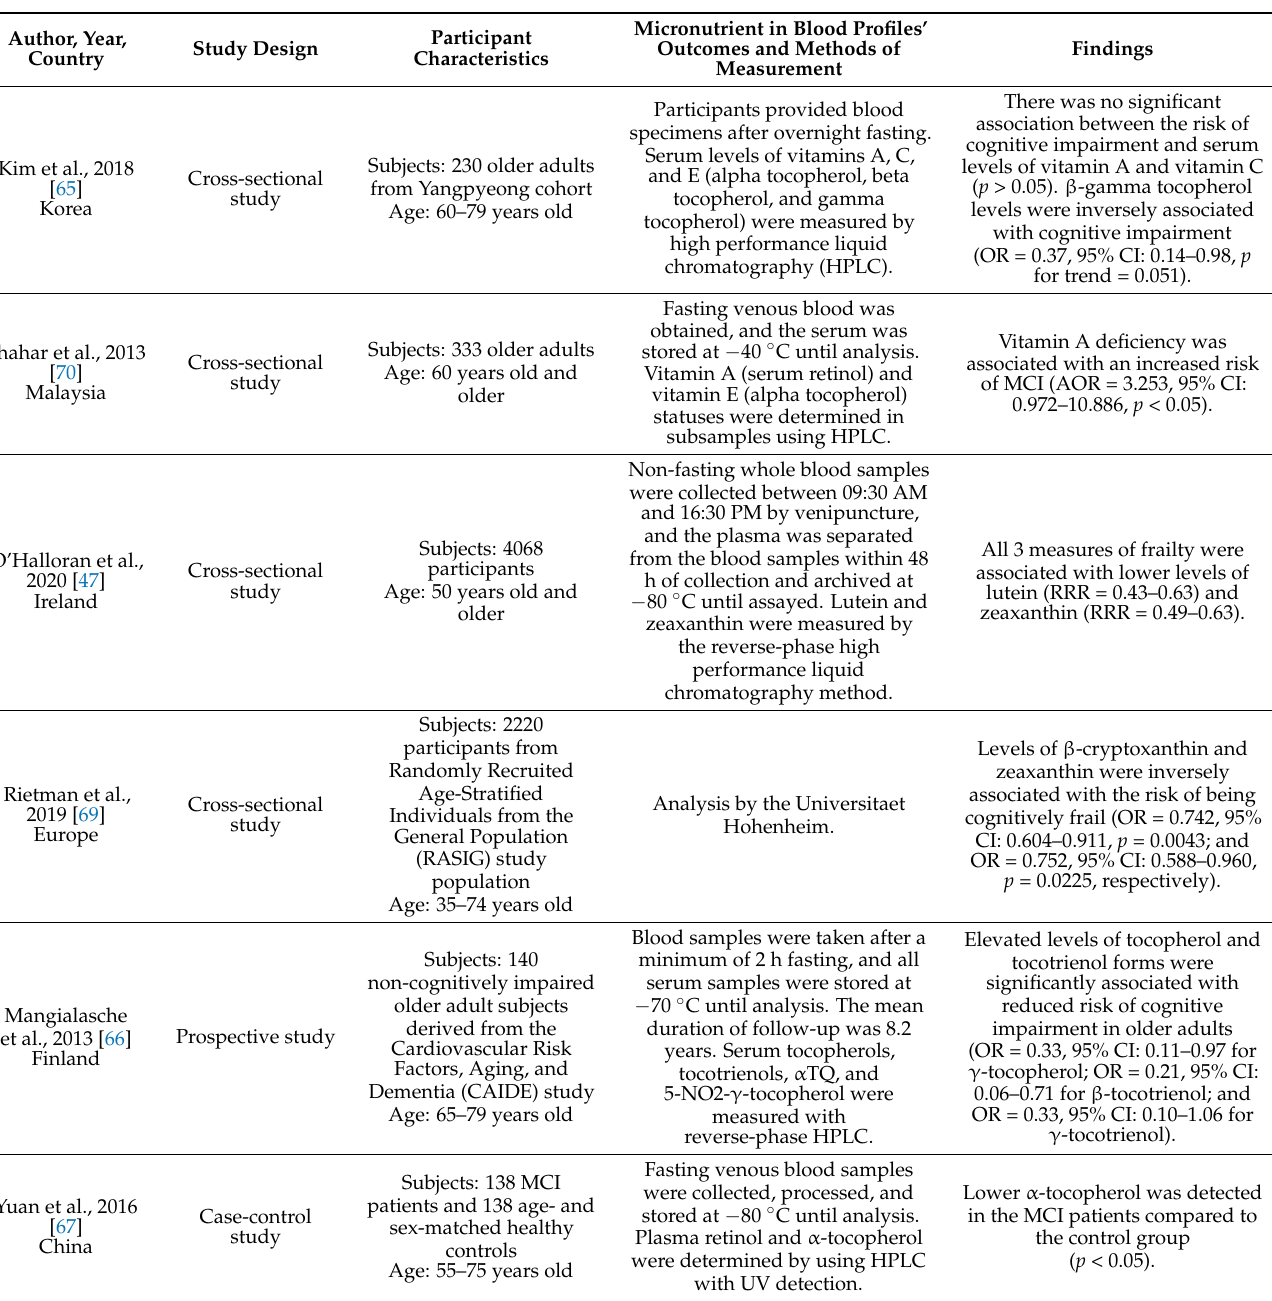
Table 5. Summary of studies evaluating the association between antioxidants with mild cognitive impairment, frailty, and cognitive frailty involved in the